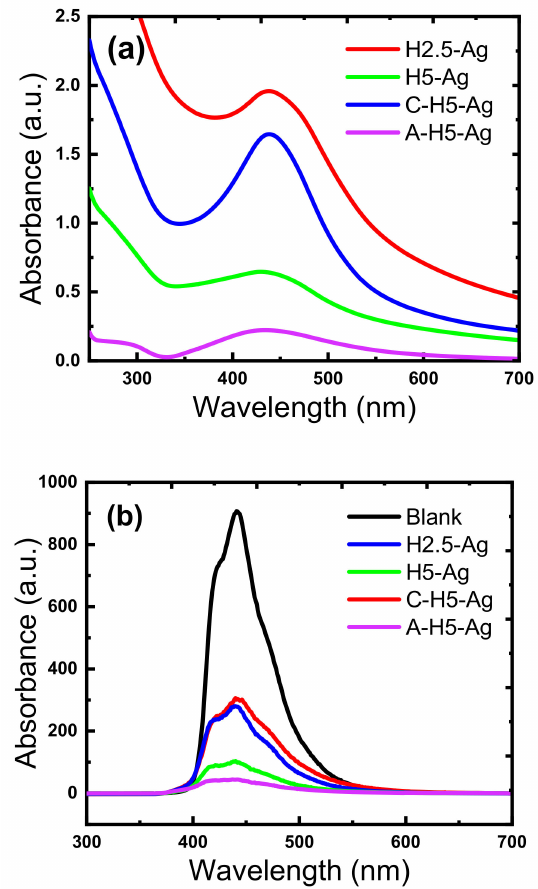
Figure 9. Spectroscopic characteristics of the blank, NPs modified (H2.5-Ag and H5-Ag), cationized (C-H2.5-Ag), and anionized (A-H5-Ag) cotton gauze samples: ( a ) UV–vis spectra of the remaining solution, and ( b ) photoluminescence